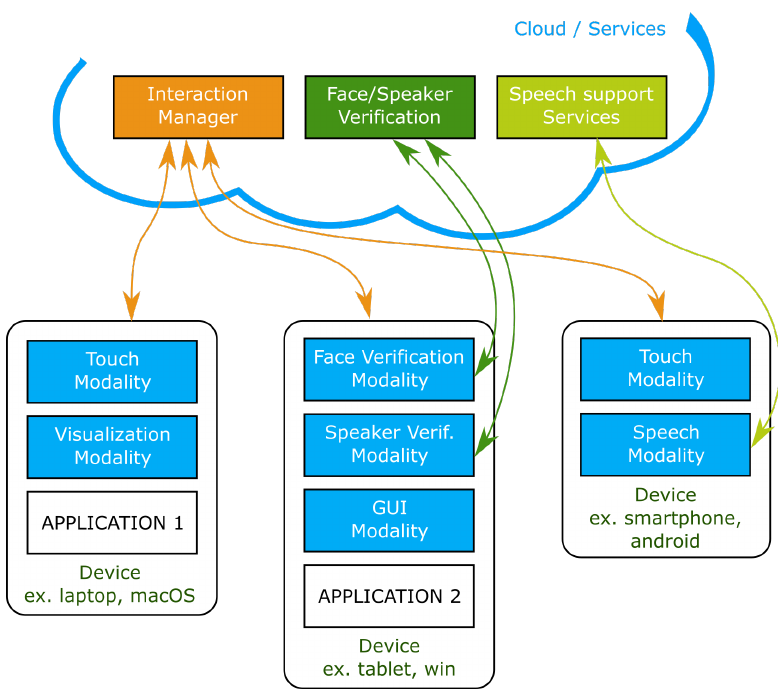
Figure 2. General view illustrating how modalities, applications and support services (in the building’s servers or the cloud) work together in an Smart Environments context. Different devices, applications and platforms are